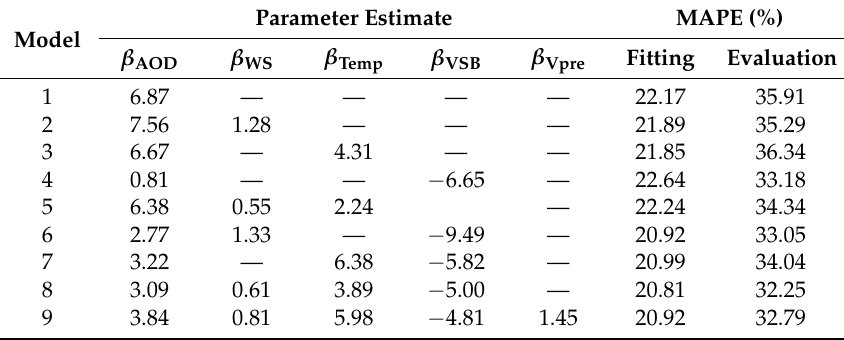
Table 5. Parameter estimations and Mean Absolute Percentage Errors (MAPEs) for GWR models 1–9 on 16 September